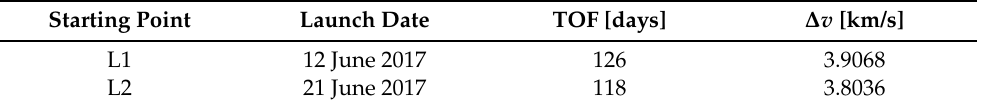
Table 2. Characteristics of the optimal interception trajectories extracted from the analysis of the porkchop plots obtained after solving the factorial scheme of Lambert’s problem.